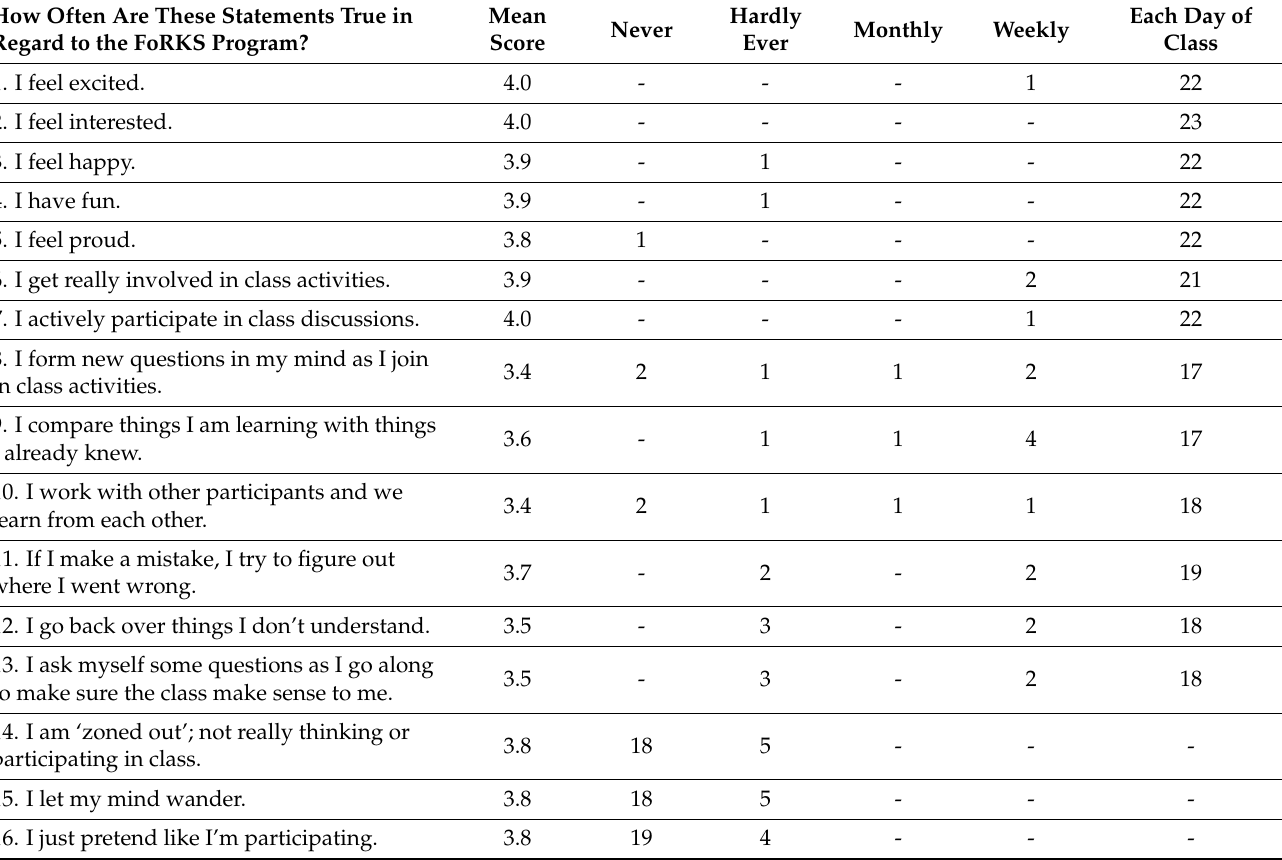
Table 3. Average score and cumulative responses of participant